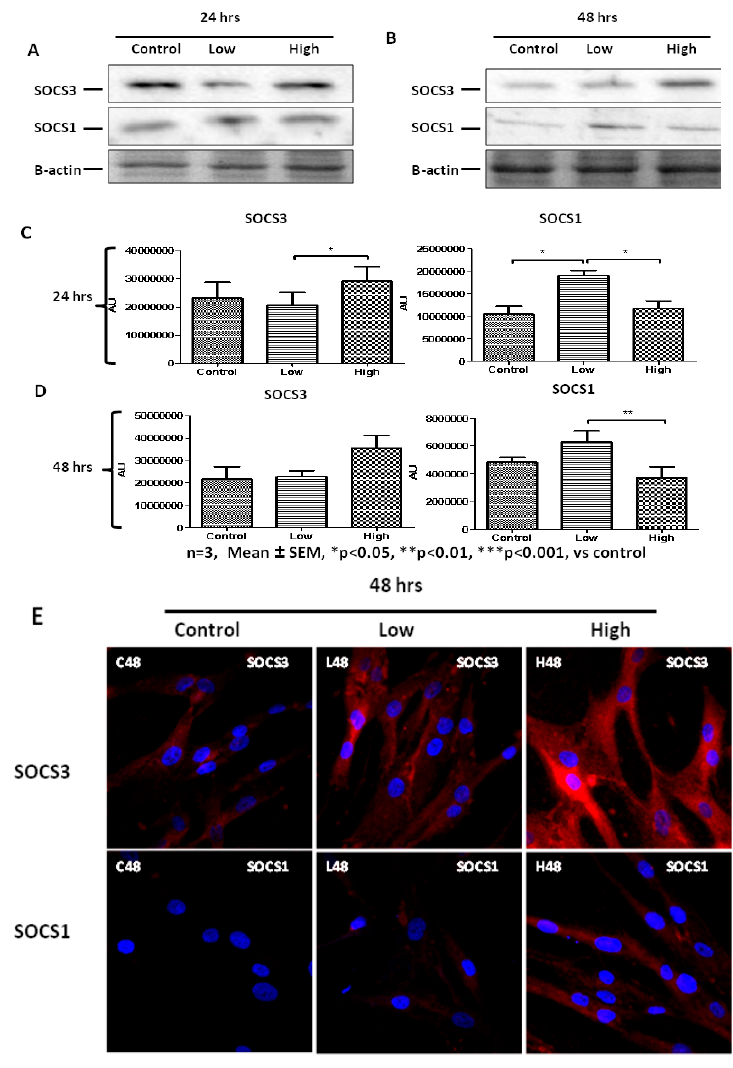
Figure 10. Concentration- and time-dependent e ff ects of low and high IL-6 concentrations on SOCS1 and SOCS3 protein levels in PHMs. ( A ) Western blot determination of SOCS3 and SOCS1 protein levels 24 h after treatment with low and high IL-6 concentrations. ( B ) Western blot determination of SOCS3 and SOCS1 protein levels 48 h after treatment with low and high IL-6 concentrations. ( C ) Quantification of SOCS3 and SOCS1 protein levels as shown in ( A ). ( D ) Quantification of SOCS3 and SOCS1 protein levels as shown in ( B ). ( E ) Immunofluorescence staining for SOCS3 and SOCS1 after treatment of PHMs with low and high IL-6 concentration for 48 h. The experiment was repeated three times. Immunofluorescence images were taken at 100 × magnification. Results are presented as mean ± standard error of the mean (S.E.M). Statistical analysis: ANOVA and Bonferroni post hoc test. * p < 0.05; ** p < 0.01.